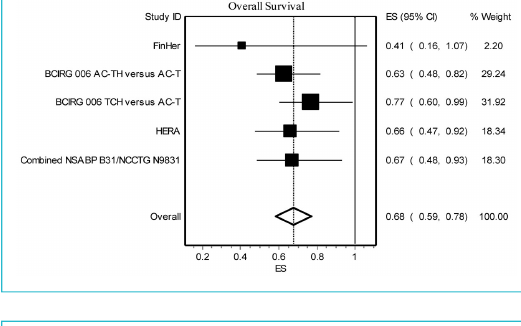
Figure 1: A meta-analysis of trastuzumab efficacy in early breast cancer (relative risk for death). AC-T, doxorubicin and cyclophos-